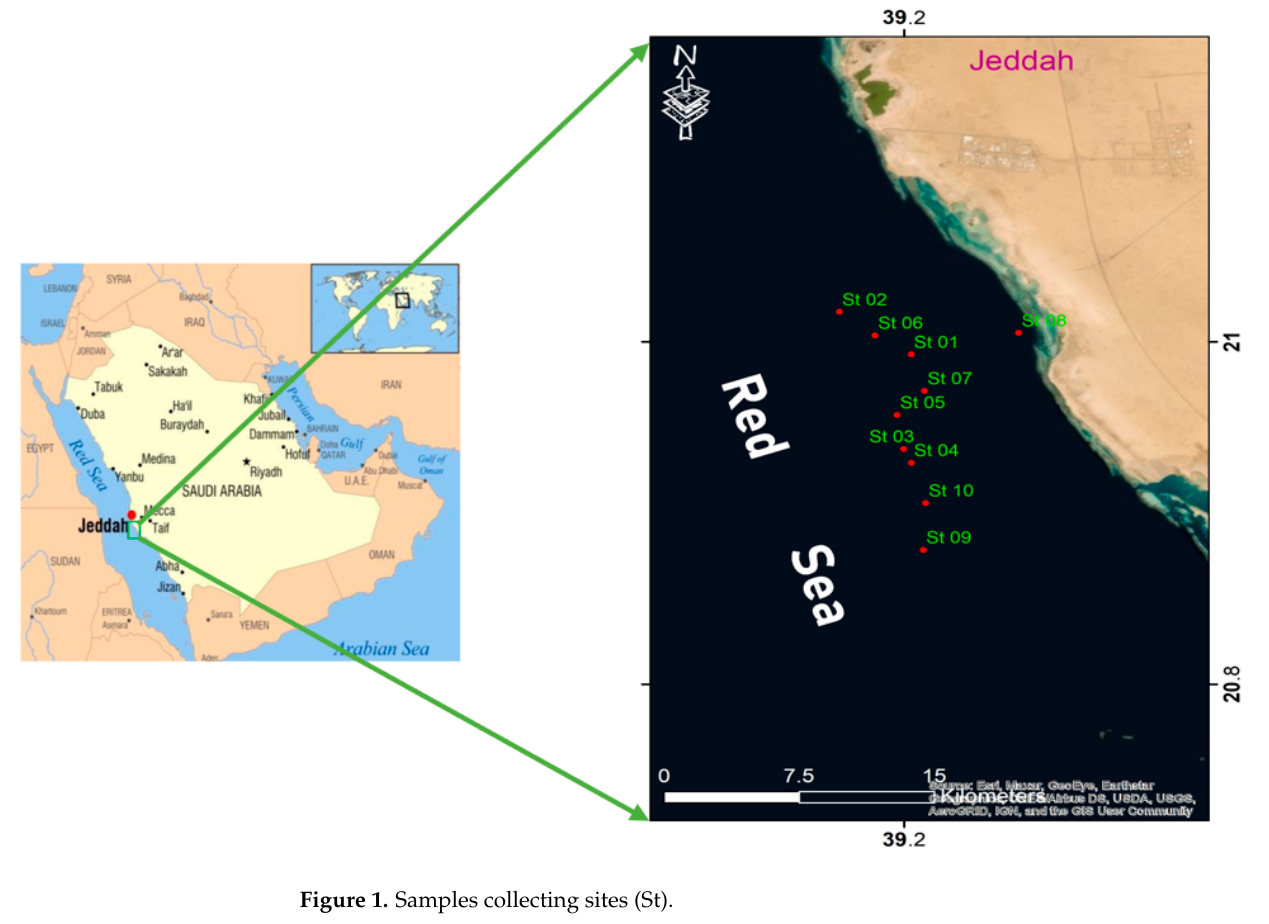
Figure 1. Samples collecting sites (St). Table 1. Sample